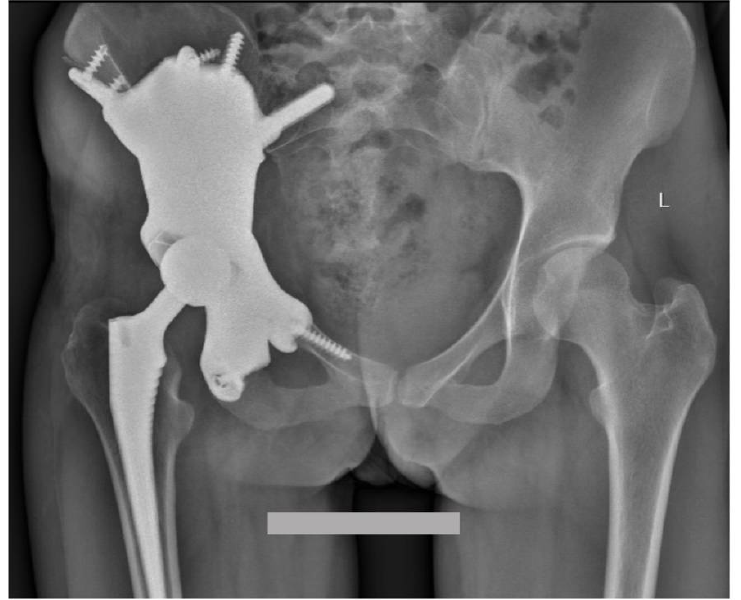
Figure 9. Pelvis AP radiography showing a custom-made 3D pelvic prosthesis in a 27 year old pa- tient. At the last follow-up at 2 years, the implant was still in site with good fixation and no local recurrence of the giant-cell tumour was